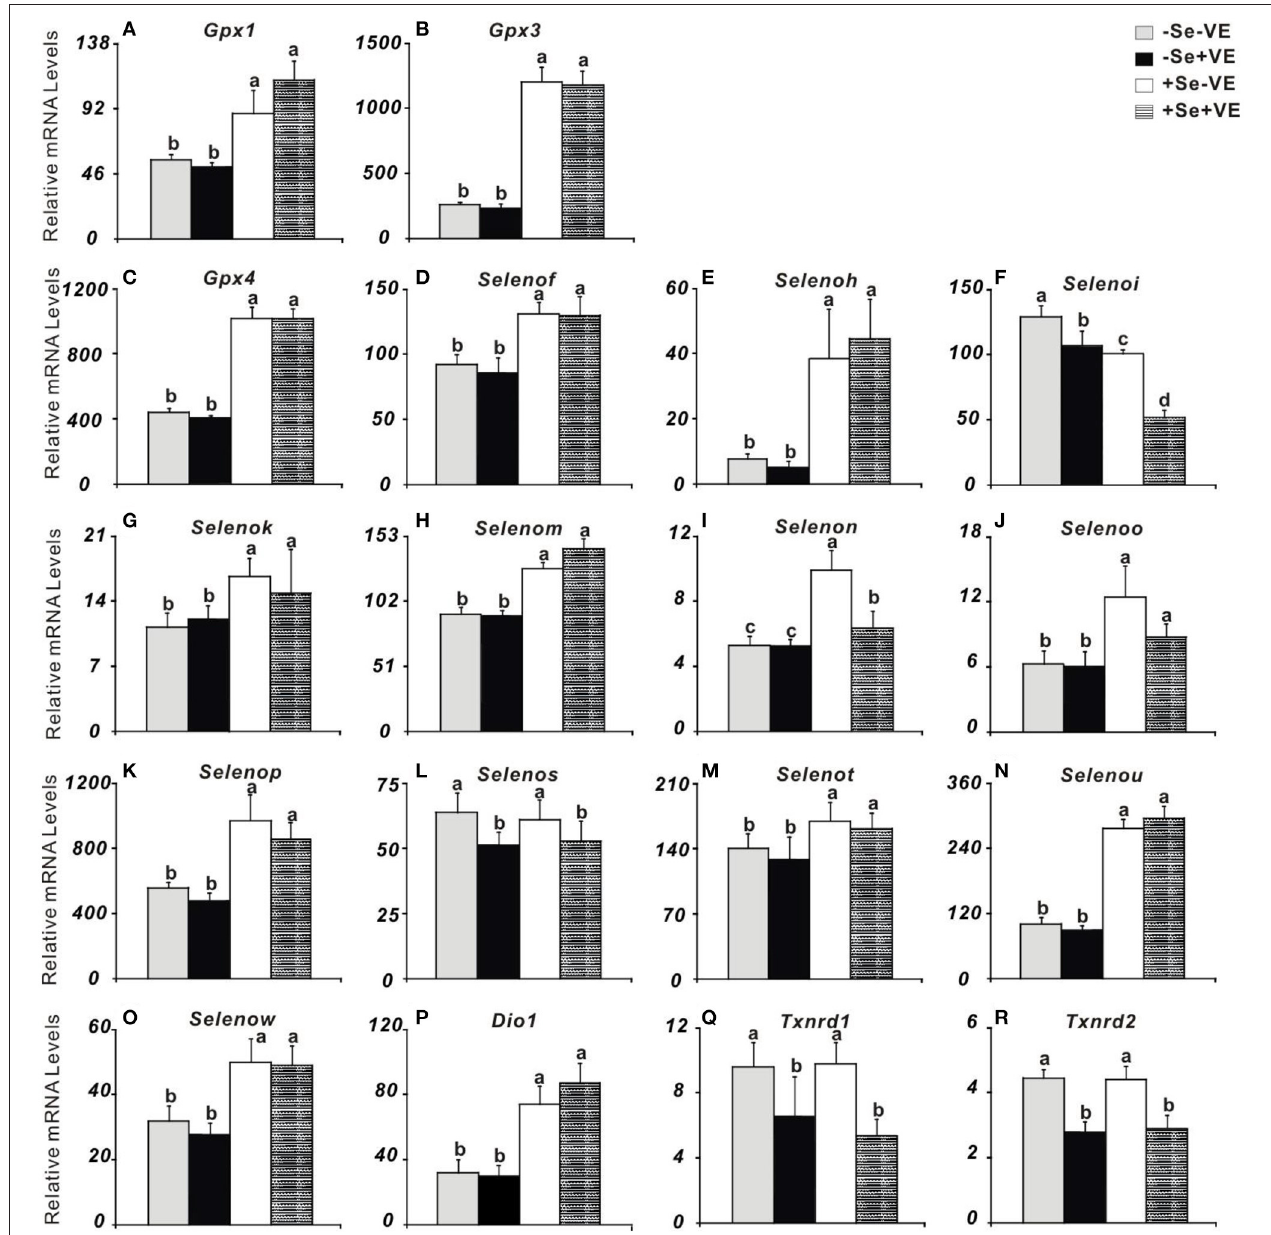
FIGURE 1 | Effects of dietary selenium (Se) and vitamin E (VE) concentrations on relative mRNA abundance of (A) Gpx1, (B) Gpx3, (C) Gpx4, (D) Selenof, (E) Selenoh, (F) Selenoi, (G) Selenok, (H) Selenom, (I) Selenon, (J) Selenoo, (K) Selenop, (L) Selenos, (M) Selenot, (N) Selenou, (O) Selenow, (P) Dio1, (Q) Txnrd1, and (R) Txnrd2 in muscle of chicks at wk 2. Data are means ± SE, n = 5. Values within a given gene differ (P < 0.05) without sharing a common superscript